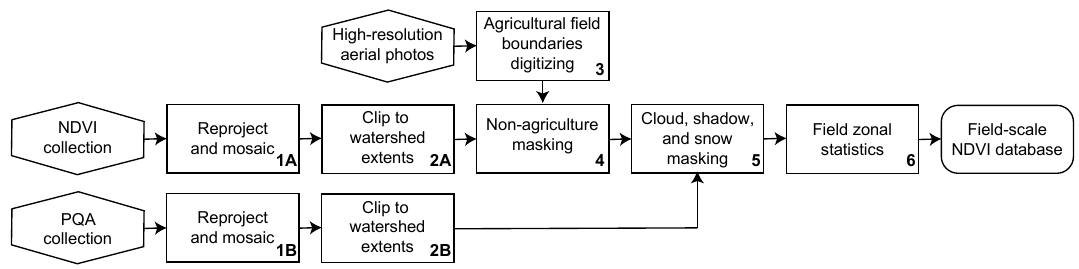
Figure 2. Simplified workflow of field-scale Normalized Difference Vegetation Index (NDVI) database development.